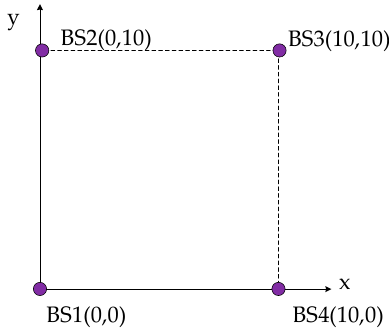
Figure 3. The layout of four sensor nodes in the simulation experiment.